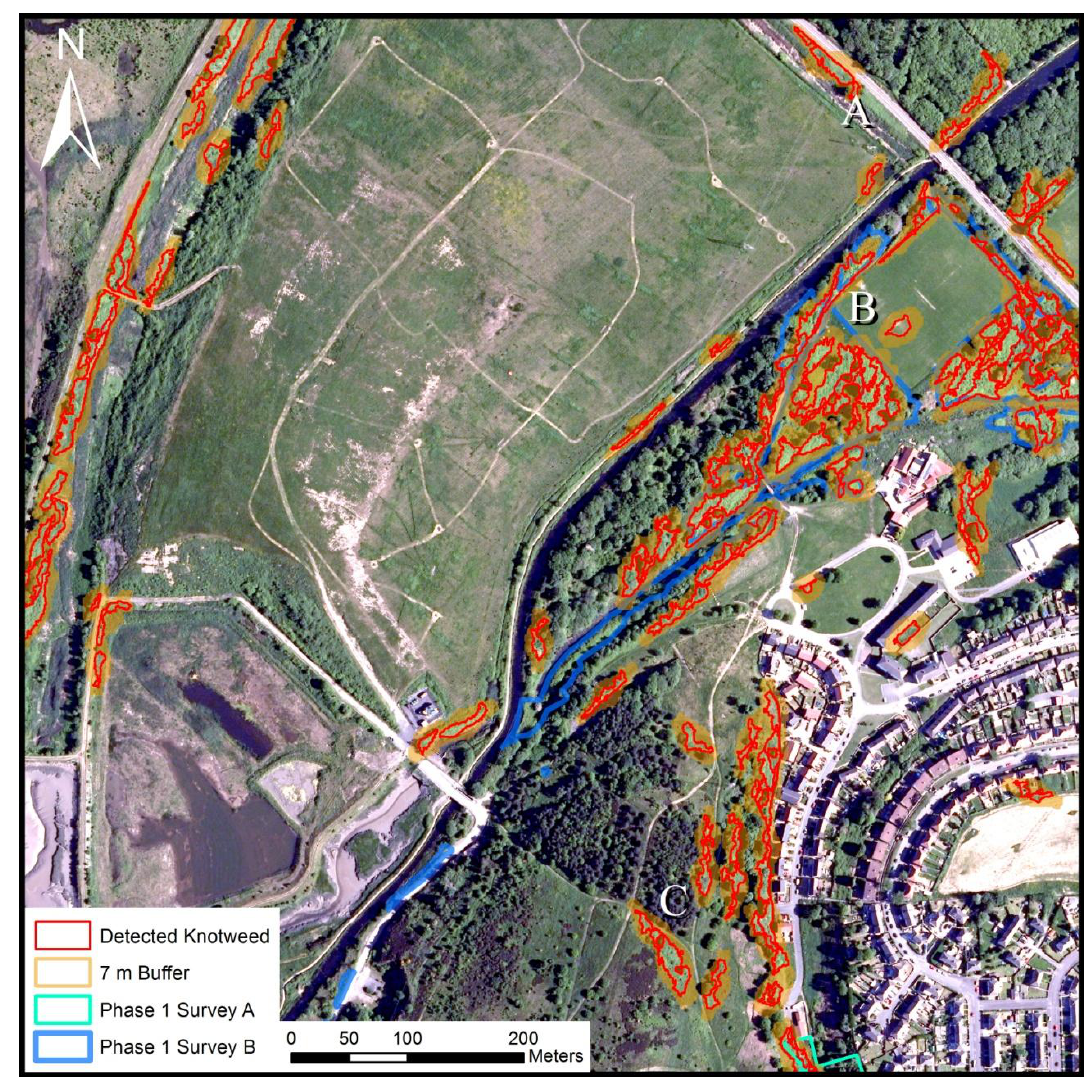
Figure 8. Giants Grave training site, Briton Ferry (South Wales, UK) (51°64′43.0″N, 03°8′24.85″W). Please refer to title and legend for further